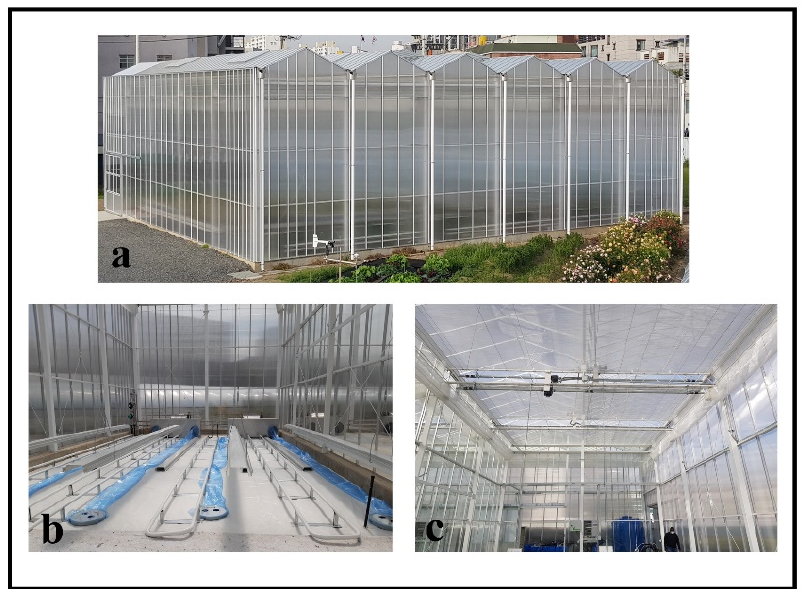
Figure 1. ( a ) Experimental greenhouse; ( b ) inside view of greenhouse partition; ( c ) installed energy screens.